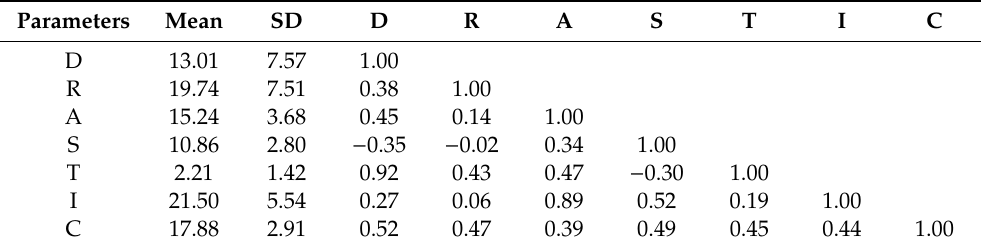
Table 8. Pairwise correlations matrix of the DRASTIC